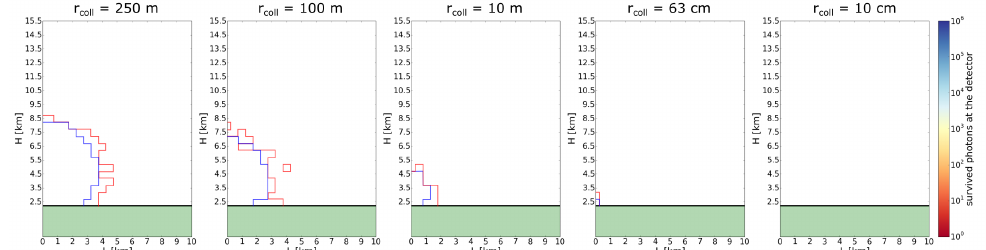
Figure 7. Comparison between the detectability regions obtained from the Geant4 numerical sim- ulations (red contour) and from the analytical treatment (blue contour), for TGFs with an initial number of 10 10 gamma-ray photons. Both approaches provide similar expected volumes around the Gamma-Flash detectors, from which TGFs can be detected, with a maximum discrepancy of ∼ 1.5 km, due to the presence of statistical fluctuations in the Monte Carlo